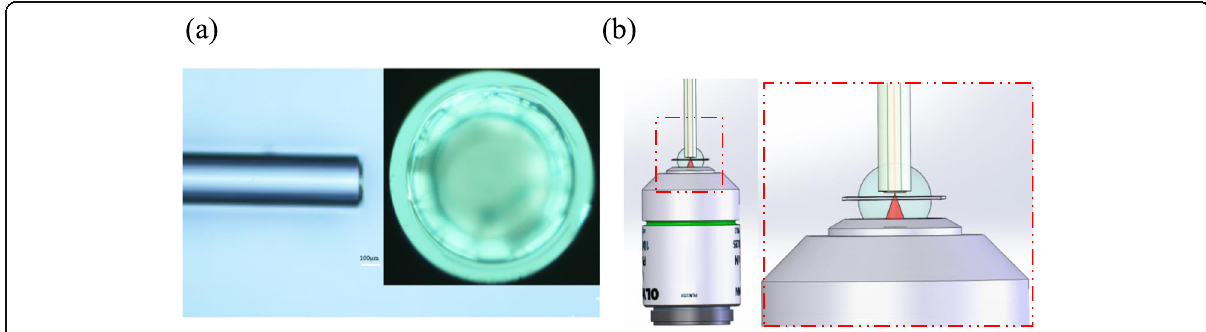
Fig. 2 Two-photon lithography using a 3D direct-laser-writing (DLW) system (Photonic Professional GT, Nanoscribe). a Left: Cross-section of the processed structure. Upper right: End face of the processed structure. b Left: Schematic diagram of the actual machining model. Right: Local enlarged figure in the dotted line box of the left